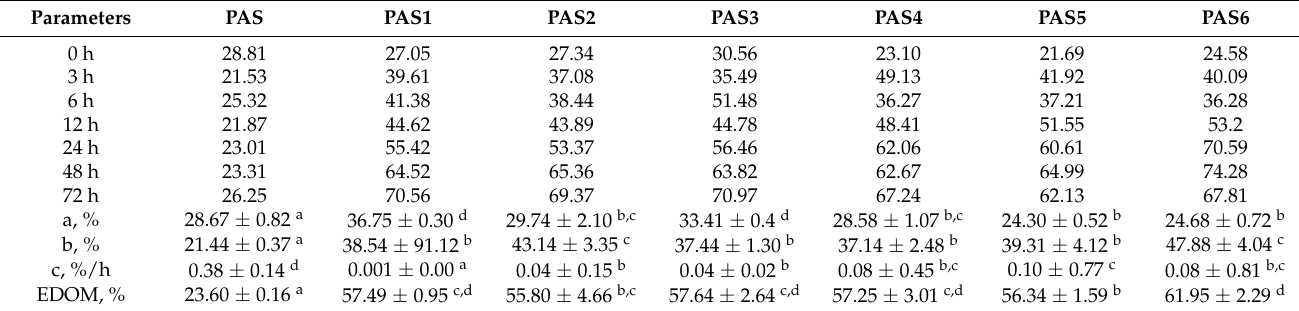
Table 3. Percentage organic-matter (OM) disappearance at different incubation periods and the effective degradability of organic matter of in vitro-incubated pineapple waste silage with or without proteolytic